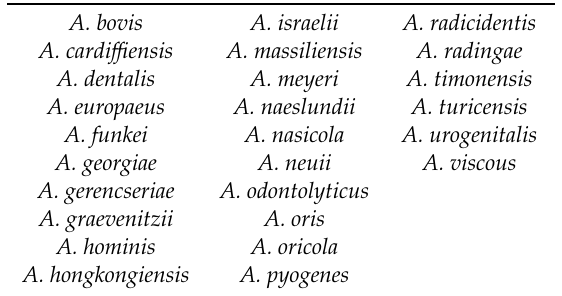
Table 1. Actinyomces species with validly published names that have been implicated in human infections (based on